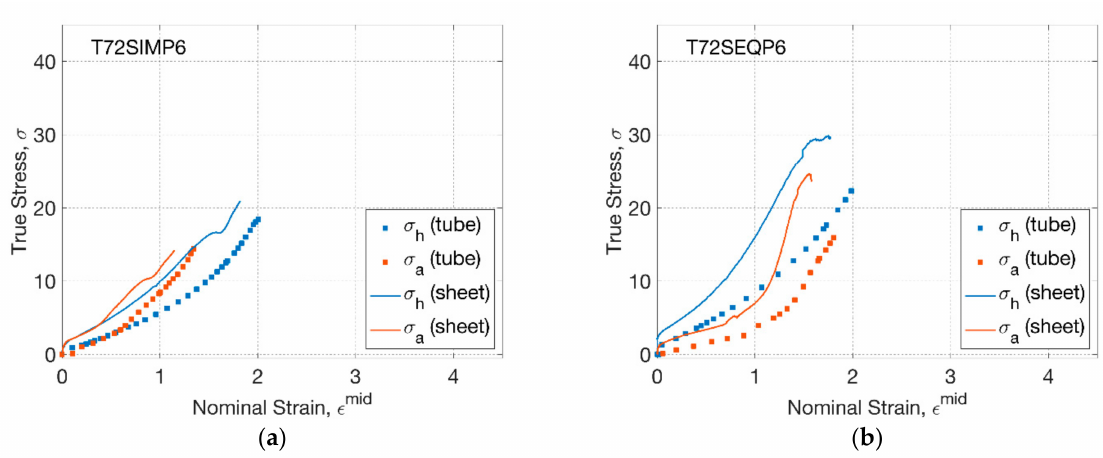
Figure 5. Stress–strain relationship of tubes and sheets: ( a ) T72SIMP6, ( b )